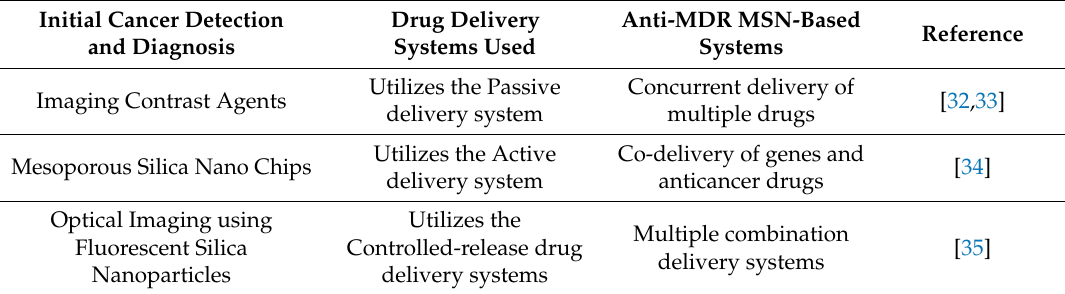
Table 1. Cancer therapy using silica